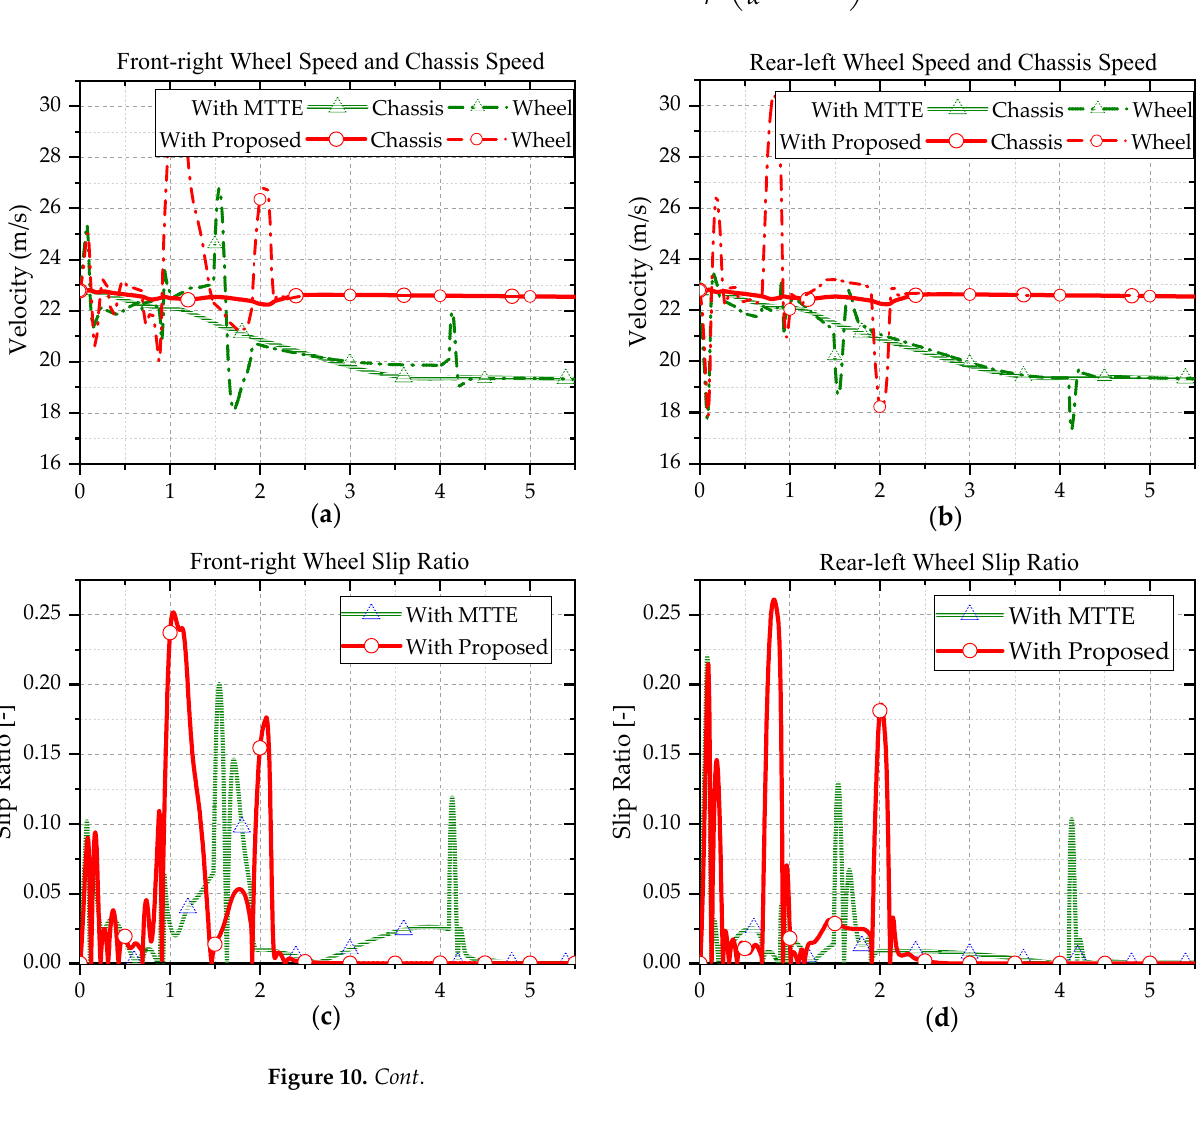
speed difference between the left and right wheels. To prevent the wheels from slipping, as shown in Figure 10a,b, MTTE will limit the speed of each wheel to the speed of the vehicle according to Equation (15). Therefore, the speed difference between the left and right wheels is reduced, increasing the tendency to understeer. Moreover, excessively restricting the wheel speed will cause the slip ratio to be too low according to Figure 10c,d, which is far from the optimal slip ratio. In particular, at around 2 s, when the vehicle makes a leftward turn to move the vehicle back to right, the wheel slip rate is limited near the value of 0. According to the tire dynamics, the wheel longitudinal force is also limited to a low value, which contributes little to the yaw moment and cannot provide enough moment to move the vehicle back to the right. As a result, as presented in Figure 10g,h, the tire lateral force maintains a large value even after 2 s, which aggravates the understeer of the vehicle. Figure 10i,j further illustrate that the longitudinal force’s yaw moment is very small, and combined with the lateral force’s yaw moment, it is not enough to bring the vehicle back into alignment. Eventually, the vehicle with MTTE fails the test.